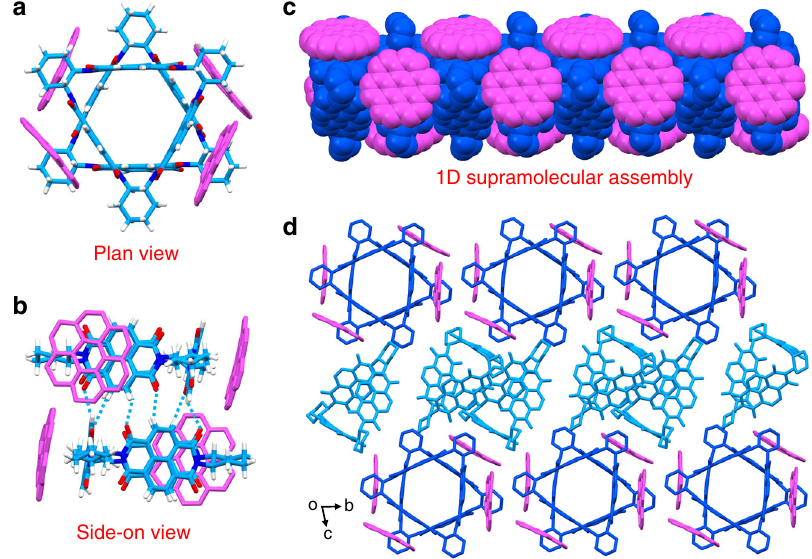
Fig. 3 Solid-state superstructure of CNC-Q. a Plan view of a capped-sticks representation illustrating that NDI- Δ and COR molecules adopt a face-to-face packing motif. b Side-on view demonstrating [C – H···O] hydrogen bonding involving two neighbor NDI- Δ molecules. c 1D Columnar superstructure composed of inner NDI- Δ nanotube and outer COR molecules. d Solid-state superstructure of CNC-Q revealing the layer-by-layer stacking along the c